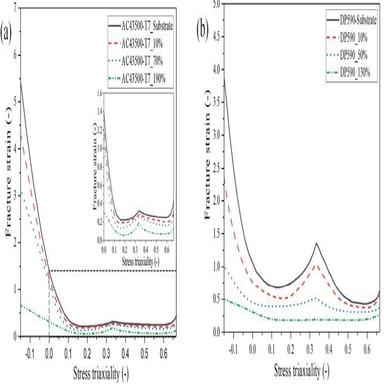
Fracture strain–stress triaxiality curves at different pre-strain levels for (a) AC43500-T7 and (b) DP590.